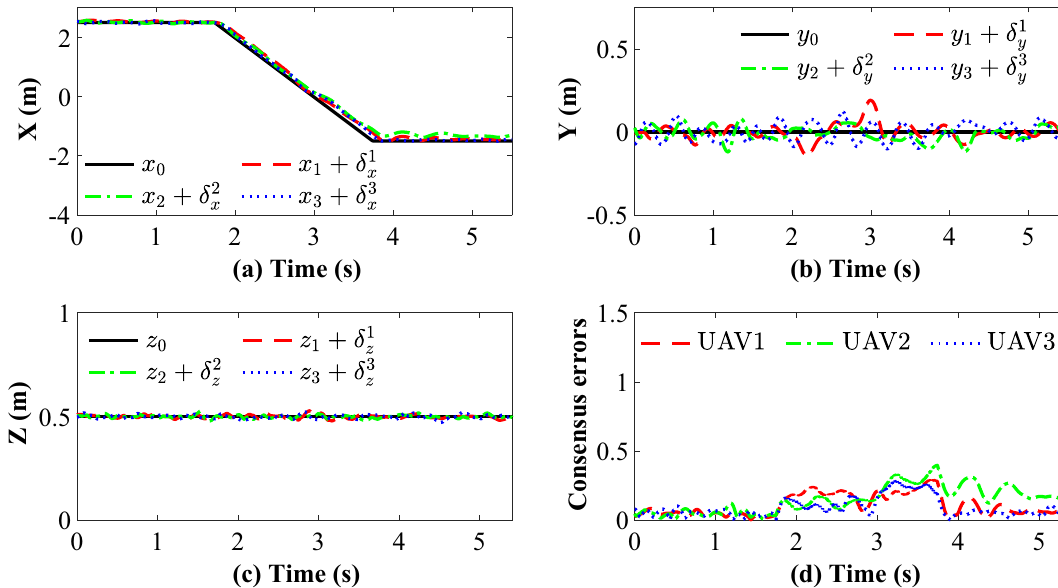
Figure 15. Experimental results: ( a ), ( b ), ( c ) and ( d ) represent X, Y, Z position trajectory and consensus error (m), respectively.